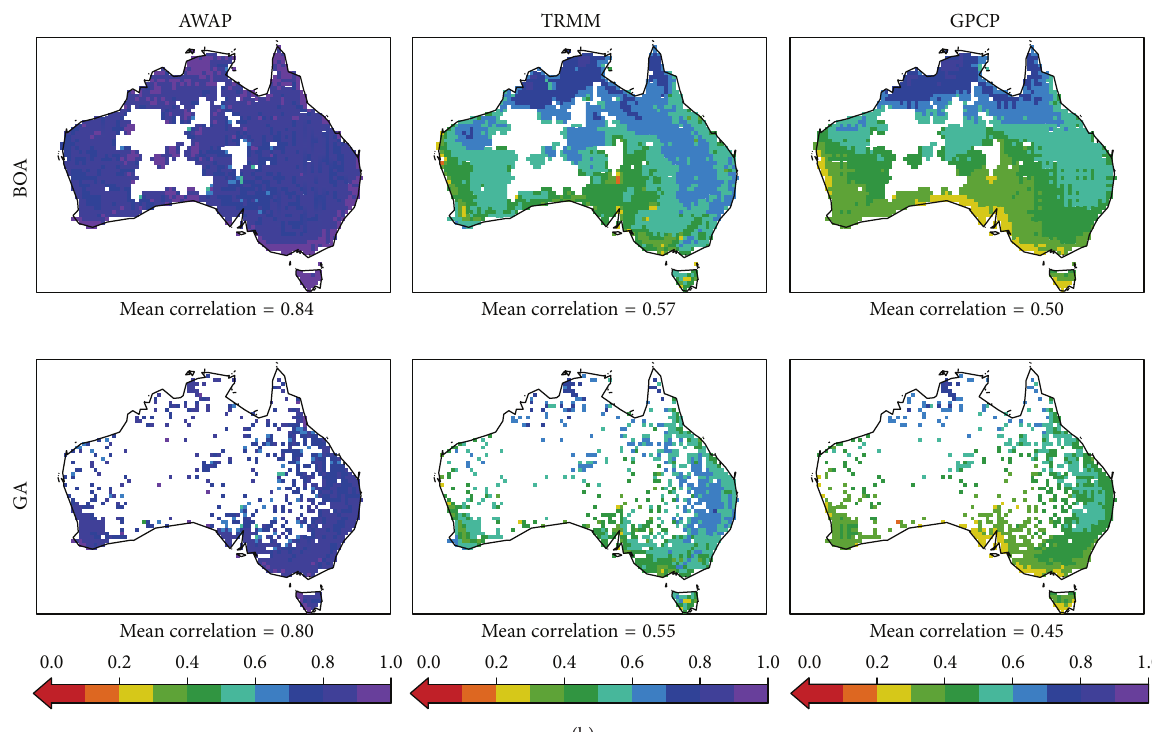
Figure 5: Maps of correlations of daily precipitation time series from 1998 to 2013 at each grid location between the seven gridded datasets created for the purposes of this study and the established gridded datasets AWAP, TRMM, and GPCP. The rows represent the seven new gridded datasets and the columns represent AWAP, TRMM, and GPCP, respectively. For example, the map in the second row of the third column depicts the correlations between CS and GPCP datasets. A negative correlation ( − 0.3) is seen only between CS and GPCP at a location south of Sydney. All mean correlations were calculated on an identical spatial domain, except for those involving GA due to the presence of additional empty grid